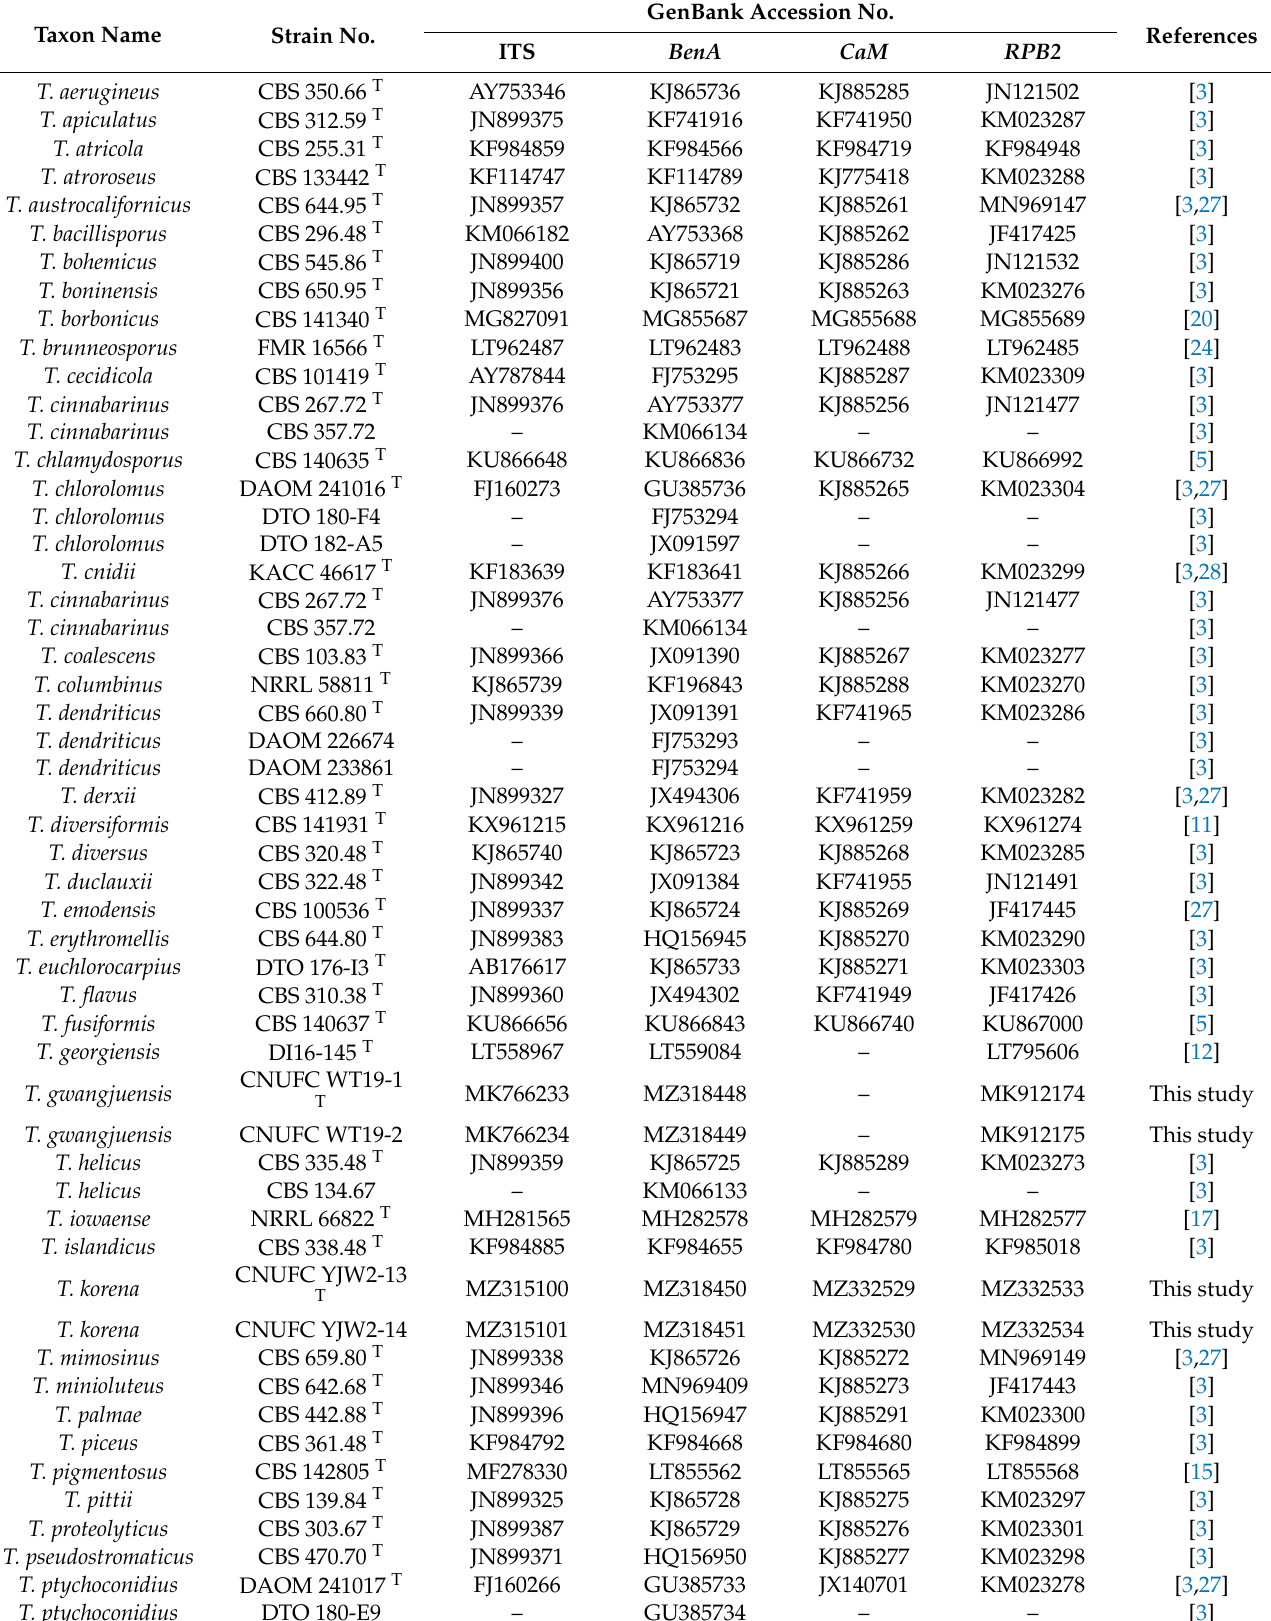
Table 1. Accession numbers for the fungal strains used for the phylogenetic